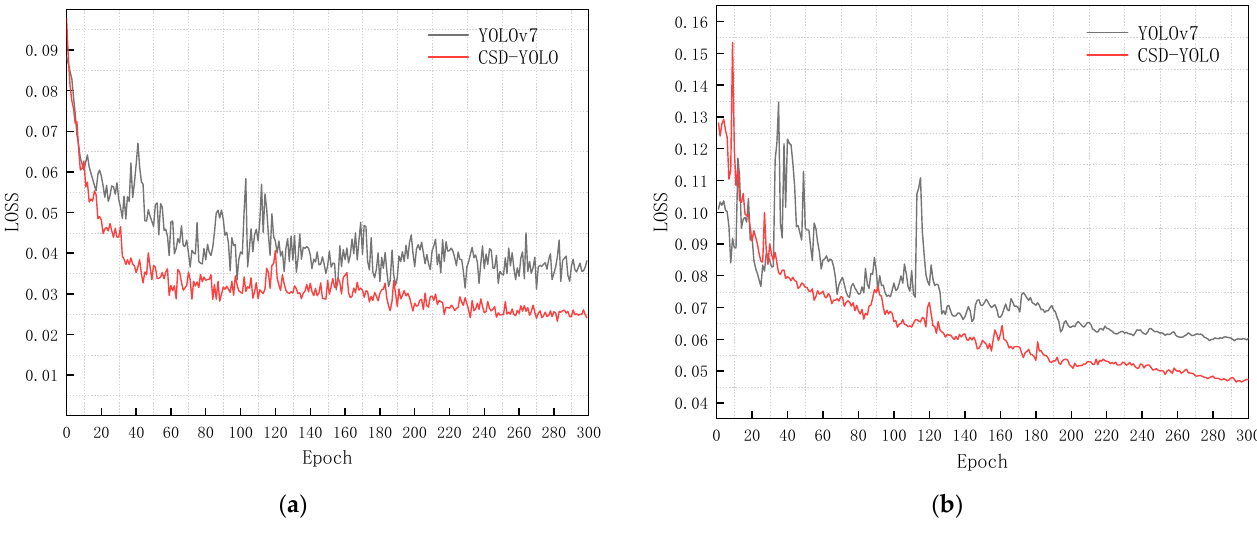
Figure 9. Bounding box loss (YOLOv7 and proposed model): ( a ) the training set bounding box loss and, ( b ) the validation set bounding box loss.